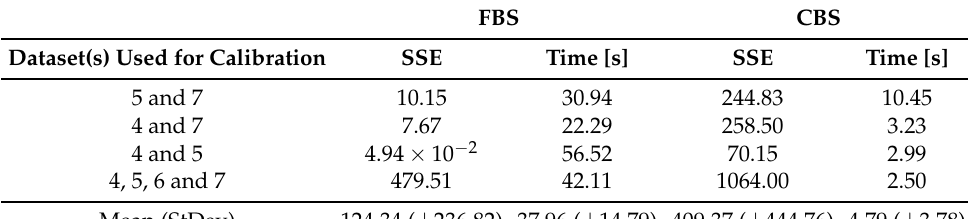
Table 3. Summary of SSEs and computation times using the FBS and CBS (S11D).